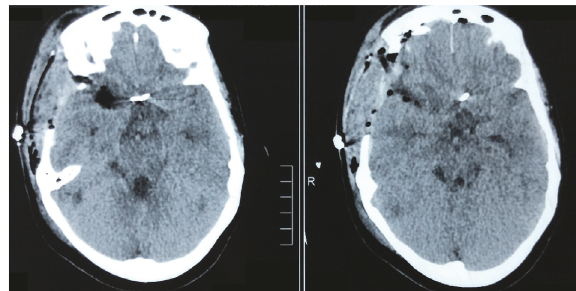
Figure 3: Postoperative plain Computed Tomogram scan of the brain showing the absence of hematoma or